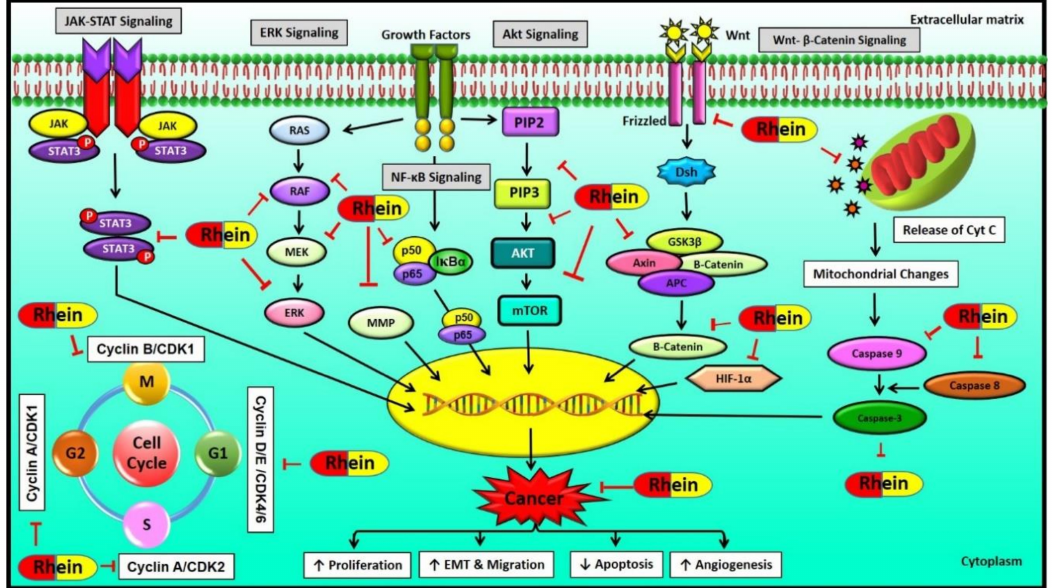
Figure 4. Mechanism of action of